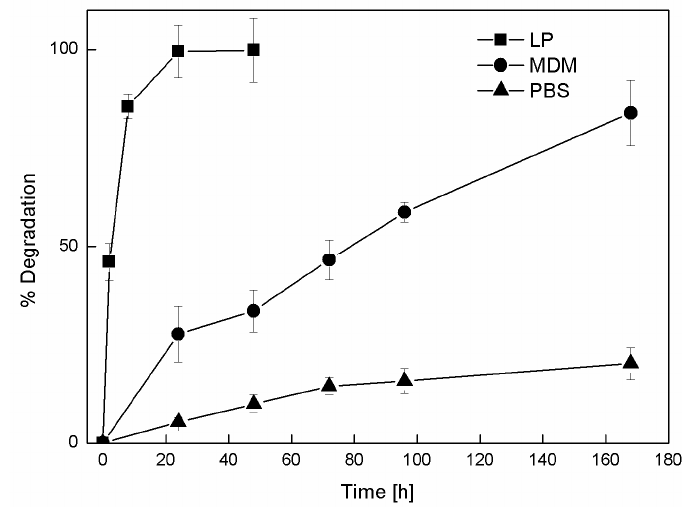
Figure 7. Evolution of NP degradation for the sample 20CL 3 PEG over time for three different media: Lipase solution (LP), cell medium (MDM), and PBS. The values and error bars represent the mean and standard deviation of three replicates.